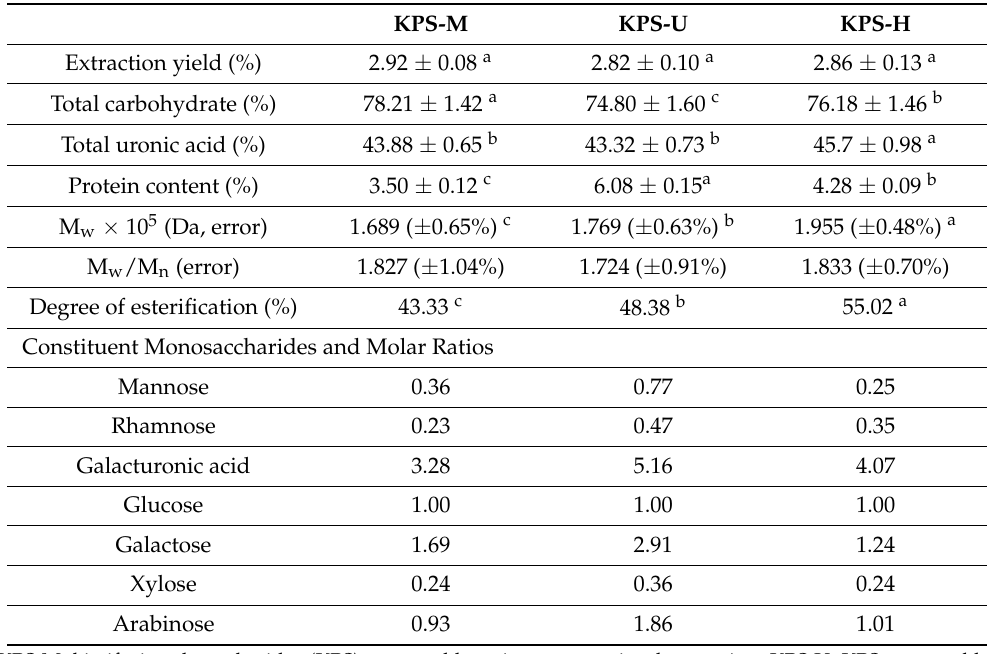
Table 3. Chemical composition, molecular weights (M w ), polydispersity (M w /M n ), and constituent monosaccharides of KPS-M, KPS-U and